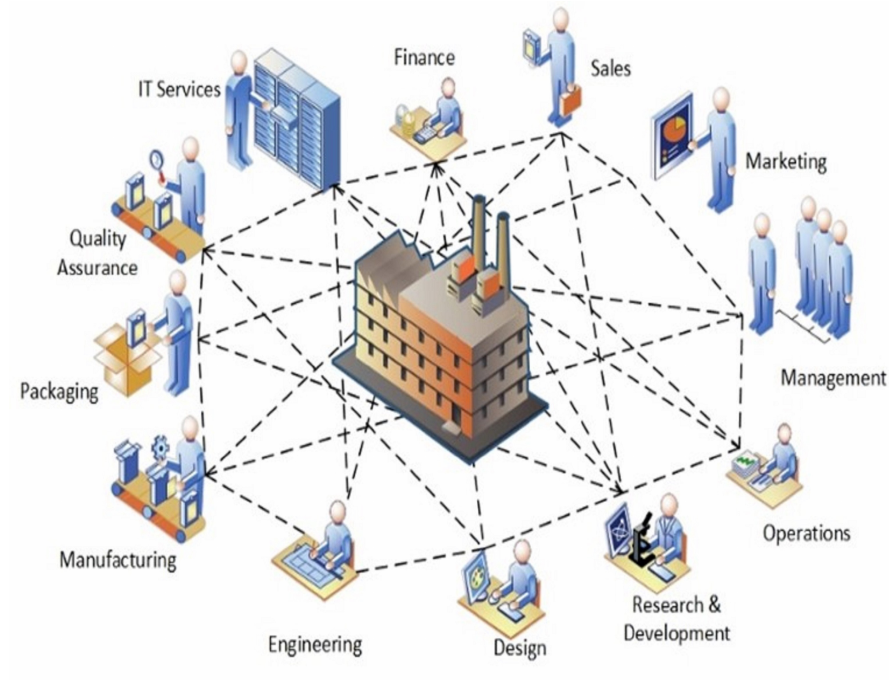
Figure 7. End-to-end